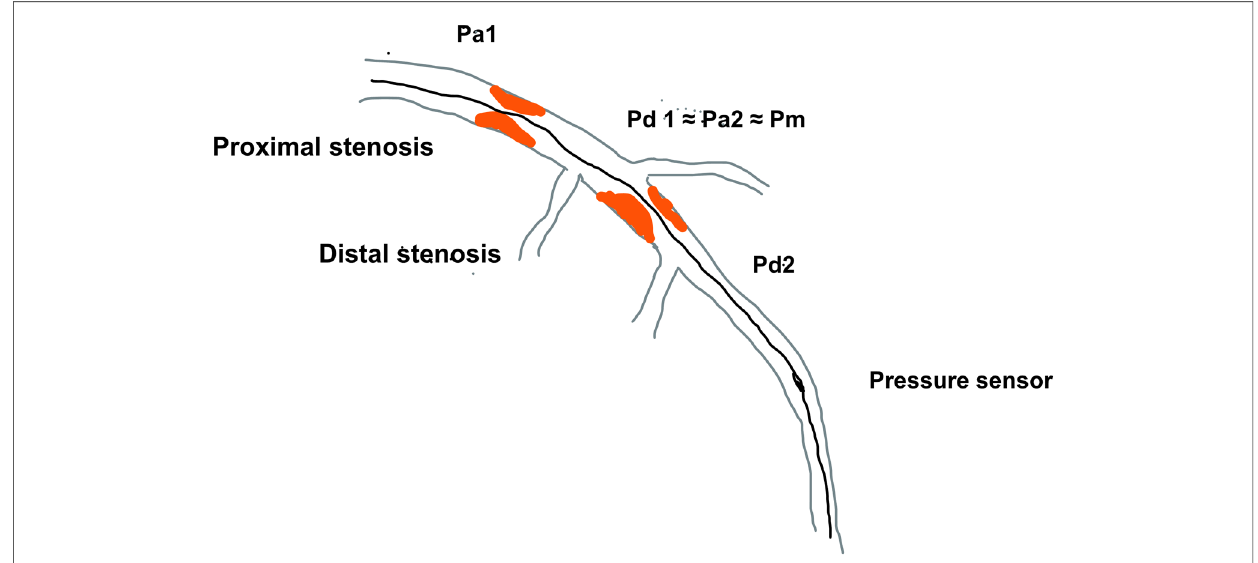
FIGURE 1 The schematic diagram of serial coronary artery stenoses and pressures measured using pressure wire Pa — proximal arterial pressure; Pd, distal arterial pressure; Pm, medial (between lesion)